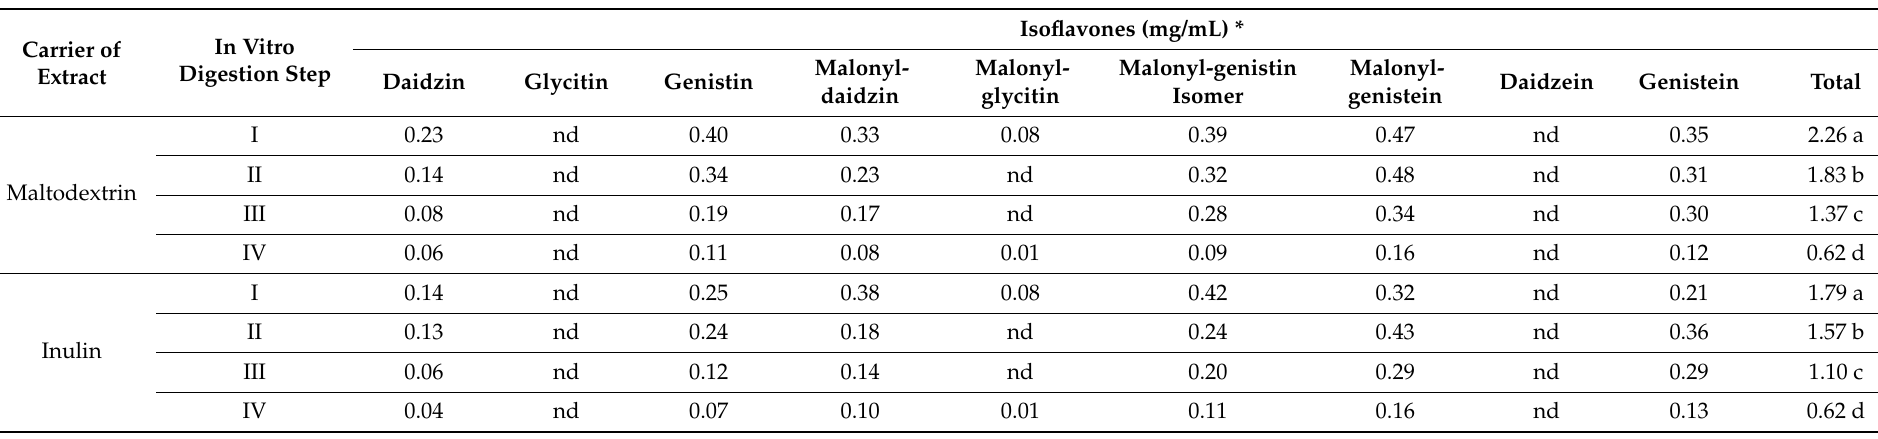
Table 1. Concentration on polyphenolic compounds (mg/mL) of liquids released during in vitro digestion of wheat bread enriched with soy extracts (SI, SM). Carrier of Extract